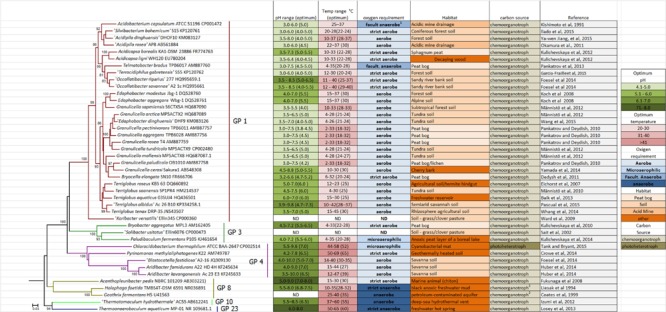
Dendrogram showing the general characteristics of Acidobacteria type species, only. The dendrogram was obtained using nearly-full 16S rRNA gene sequences obtained and aligned using the Ribosomal Database Project. Dendrogram were obtained with MEGA7 (Tamura et al., 2011) using the Neighbor-joining method (Saitou and Nei, 1987); bootstrapping values were based on 1000 repetitions and are shown next to the branches (Felsenstein, 1985). There were a total of 1343 positions in the final dataset. 1. Acidobacterium capsulatum was originally described as an aerobic bacteria, but later it was demonstrated a weak anaerobic growth by fermentation (Pankratov et al., 2012). 2. H. foetida is homoacetogen and G. fermentans is fermentative. ND, not determined. Quote marks (‘) indicate that this species is deposited in a culture collection, but its name does not retain its validity and standing in nomenclature.